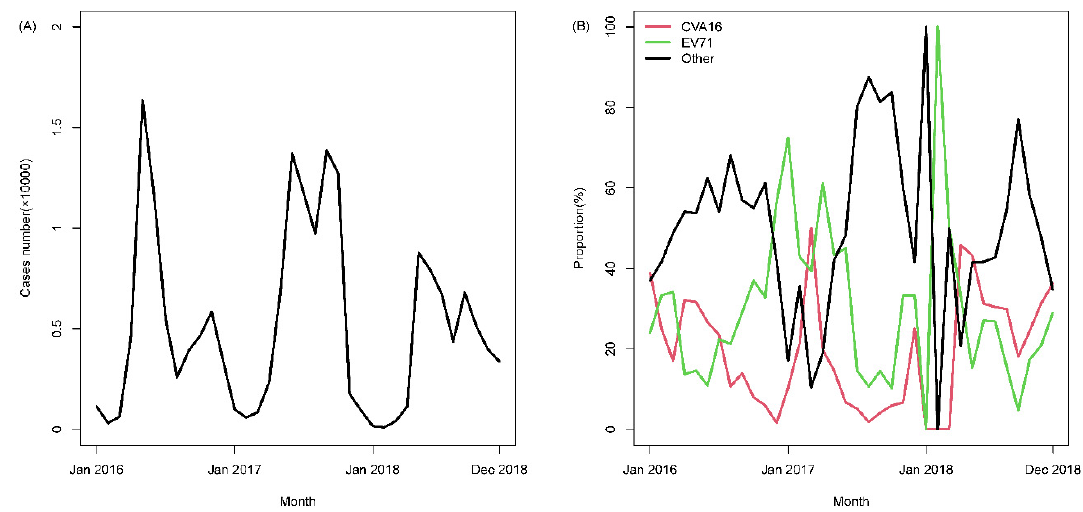
Figure 2. Observed trends in case numbers and genotype frequency of HFMD from 2016 to 2018 in Guangzhou, China. ( A ) Case number of HFMD; ( B ) genotype frequency of HFMD.